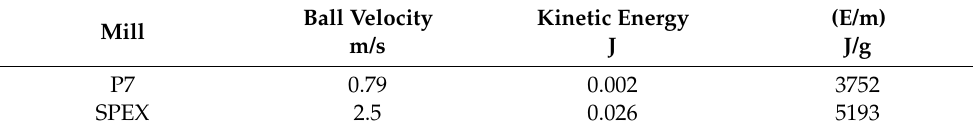
Table 7. Ball velocity, kinetic energy, and total energy of Spex and P7. Ball Velocity Kinetic Energy Mill m/s